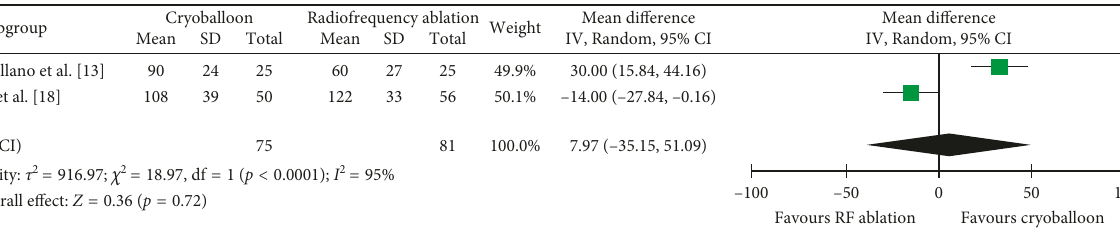
Figure 8: Mean ablation time in minutes with 95% CI in patients receiving cryoballoon versus radiofrequency